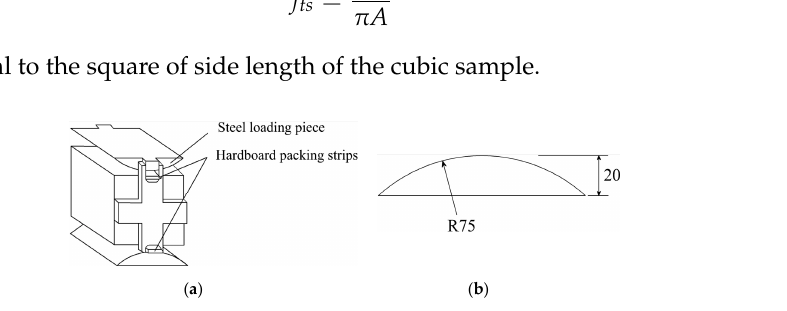
Figure 6. Illustration of splitting tensile strength test: ( a ) Loading configuration; ( b ) Sizes of steel loading piece.